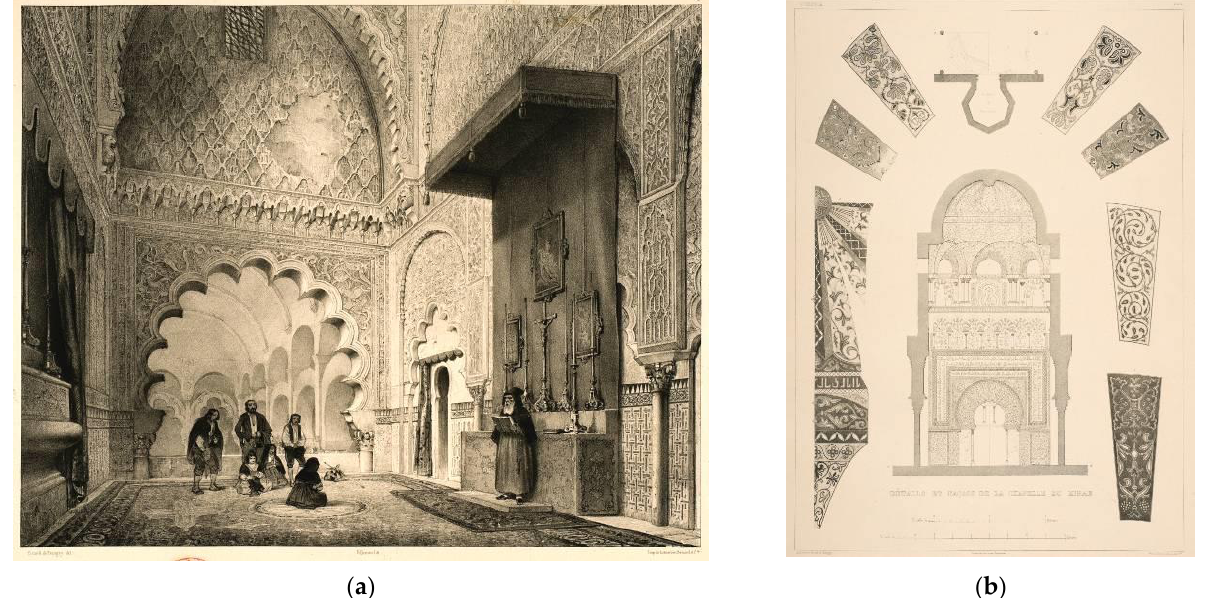
Figure 8. Girault de Prangey: ( a ) Royal Chapel side view (Villemin, lit.); ( b ) Section-elevation and details from mihrab (Dumouxa, lit.). Source: Monuments arabes et moresques de Cordoue, 1839.